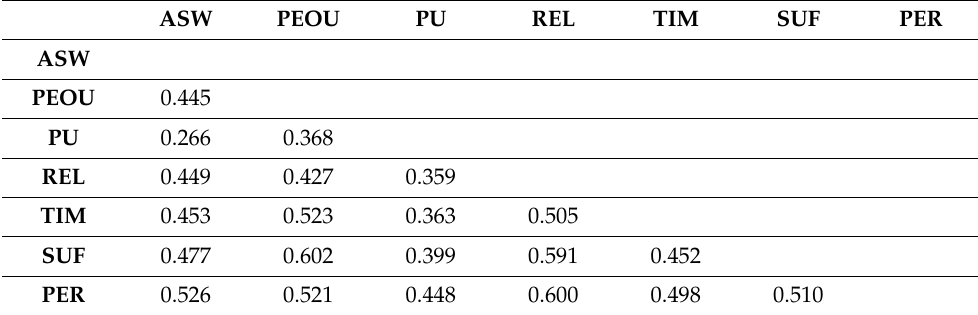
Table 7. Heterotrait-Monotrait Ratio